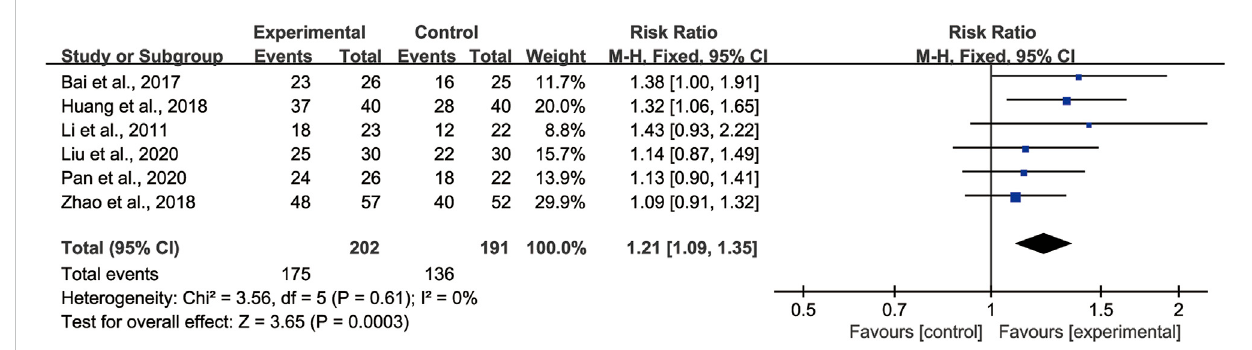
FIGURE 7 Forest plot of clinical ef fi cacy rate: CHMs plus CTX treatment versus CTX treatment.